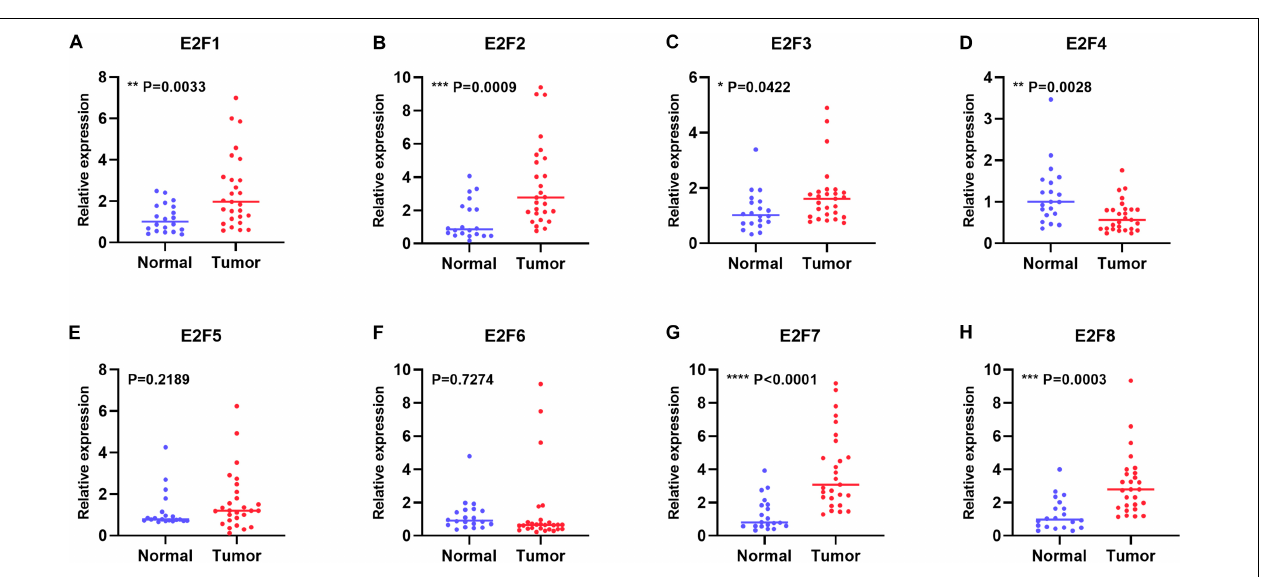
FIGURE 2 | The relative level of E2Fs in normal and UCEC tissues. Scatter plots showed the relative level of E2F1 (A) , E2F2 (B) , E2F3 (C) , E2F4 (D) , E2F5 (E) , E2F6 (F) , E2F7 (G) , and E2F8 (H) in UCEC tissue and normal